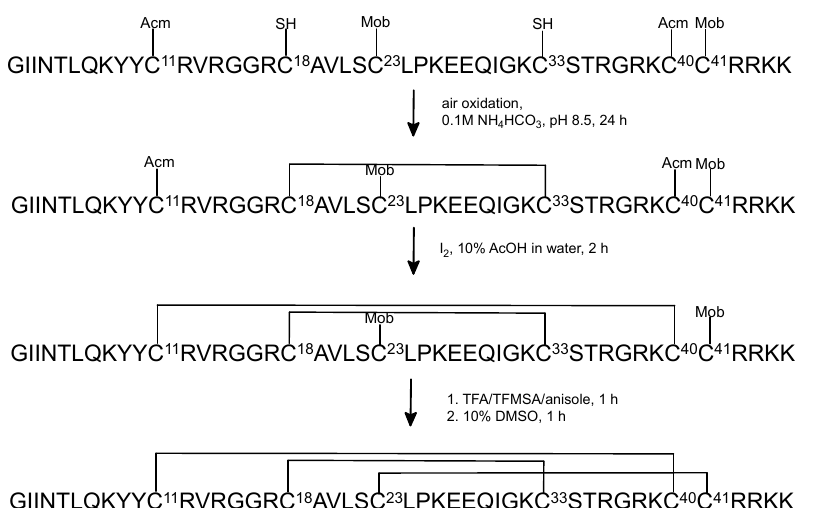
Figure 3. The scheme of regioselective oxidative folding of HBD-3 with Trt/Acm/Mob orthogonal group pattern.